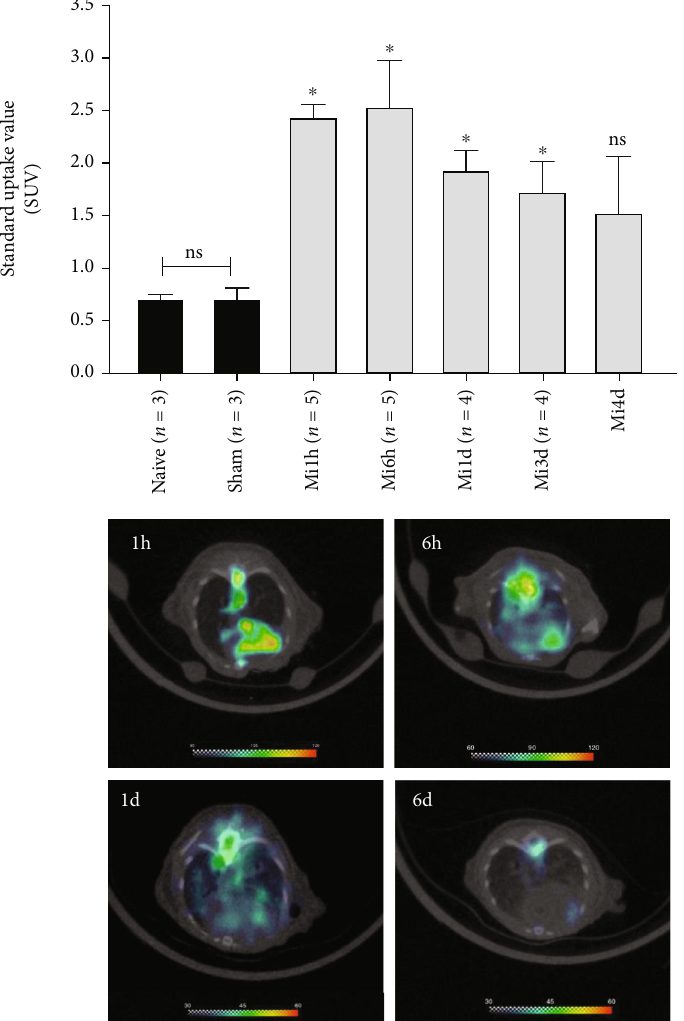
Figure 3: Cardiac SUV of 18 F-FGA at various times after MI ( mean ± sem ; ∗ p < 0 : 05 vs. sham). The lower panel shows representative tomograms of mice imaged after 1 h, 6 h, 1d, and 3 d after